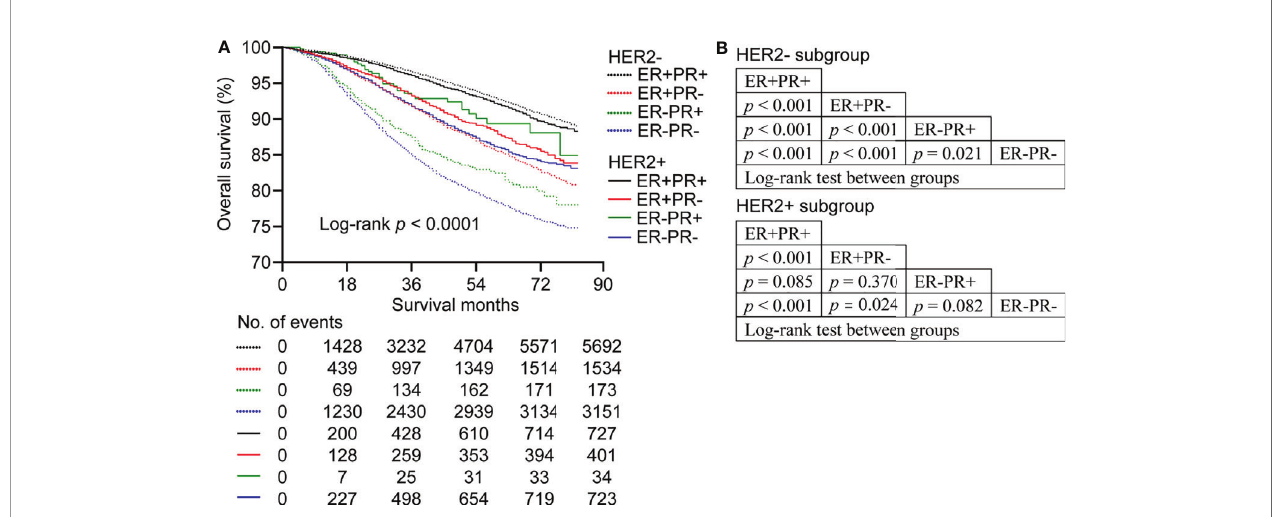
FIGURE 1 | Overall survival of patients strati fi ed by estrogen receptor (ER), progesterone receptor (PR) and human epidermal growth factor Receptor 2 (HER2) status before propensity score matching. (A) Kaplan-Meier survival curves of overall survival. (B) League table of comparison by log-rank